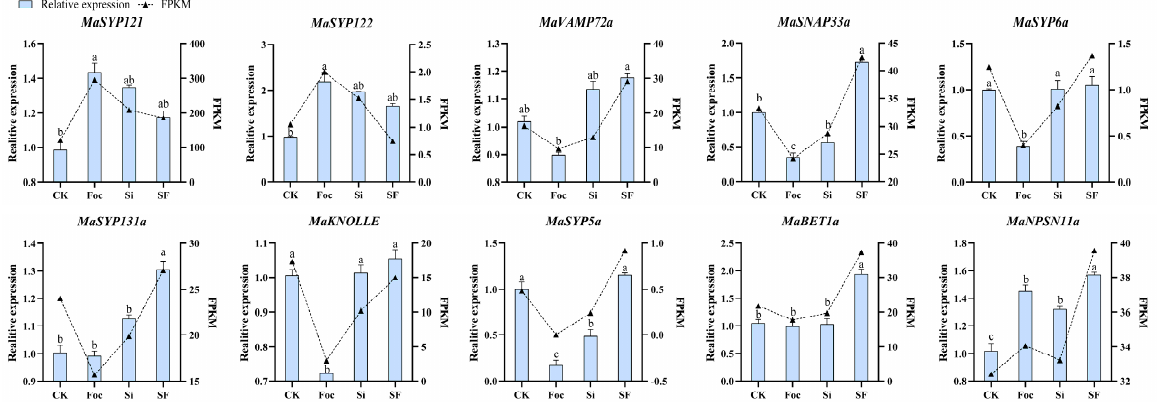
Figure 7. Heatmap for the expression of MaSNAREs in Foc TR4-, S. indica -, and their co-treated ba- nana roots. ( A – E ): Qa, Qb, Qc, Qbc and R subfamily, respectively. CK: banana roots without S. indica and Foc TR4 treatments. Average FPKM values of three biological replications were used for the heatmap drawing. The redder the color, the higher the expression level; the bluer, the lower the expression level.